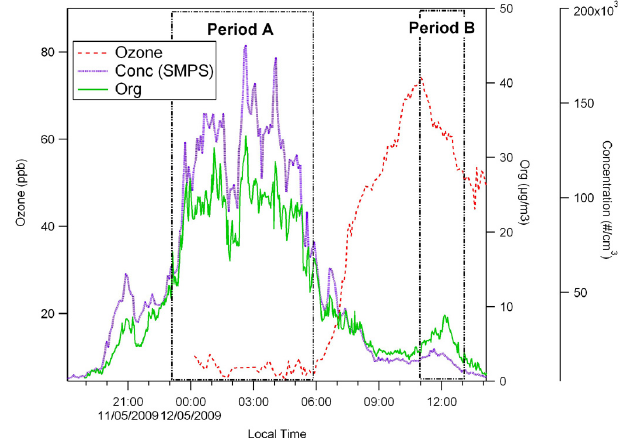
Fig. 10. The organics mass, the total concentration of the SMPS (# cm − 3 ) and ozone concentration (ppb) plotted as a function of local time, during the burning event (period A) and the following day (period